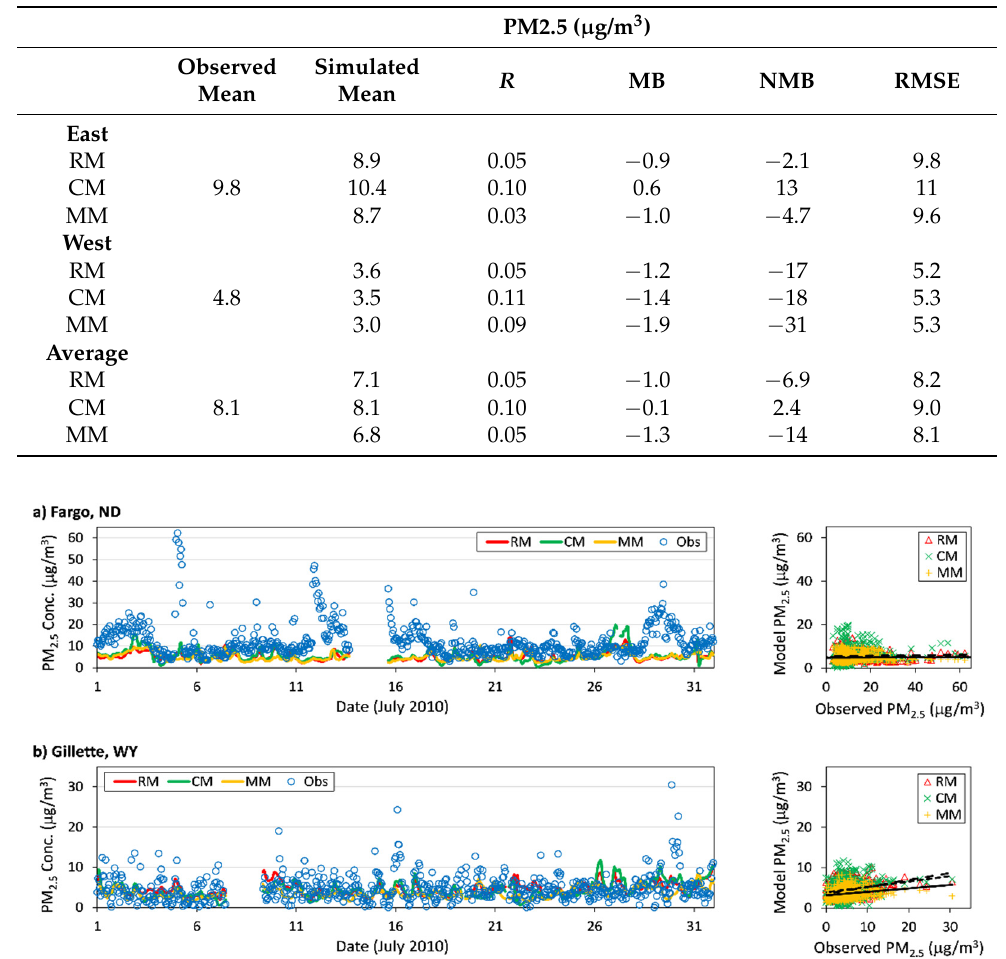
Figure 9. Hourly observed (Obs) and simulated PM2.5 concentrations ( μ g/m3) from RACM- MADE/SORGAM (RM), CBMZ-MOSAIC (CM), and MOZART-MOSAIC (MM) chemistry-aerosol mechanisms. Time series shown on left, with scatter plots of simulated vs. observed values on the right for ( a ) Fargo, ND and ( b ) Gillette, WY.